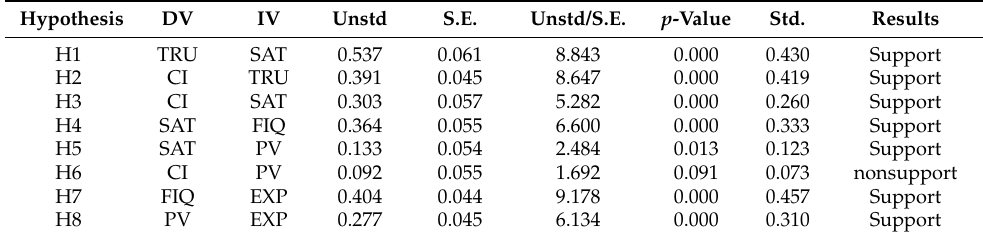
Table 7. Regression